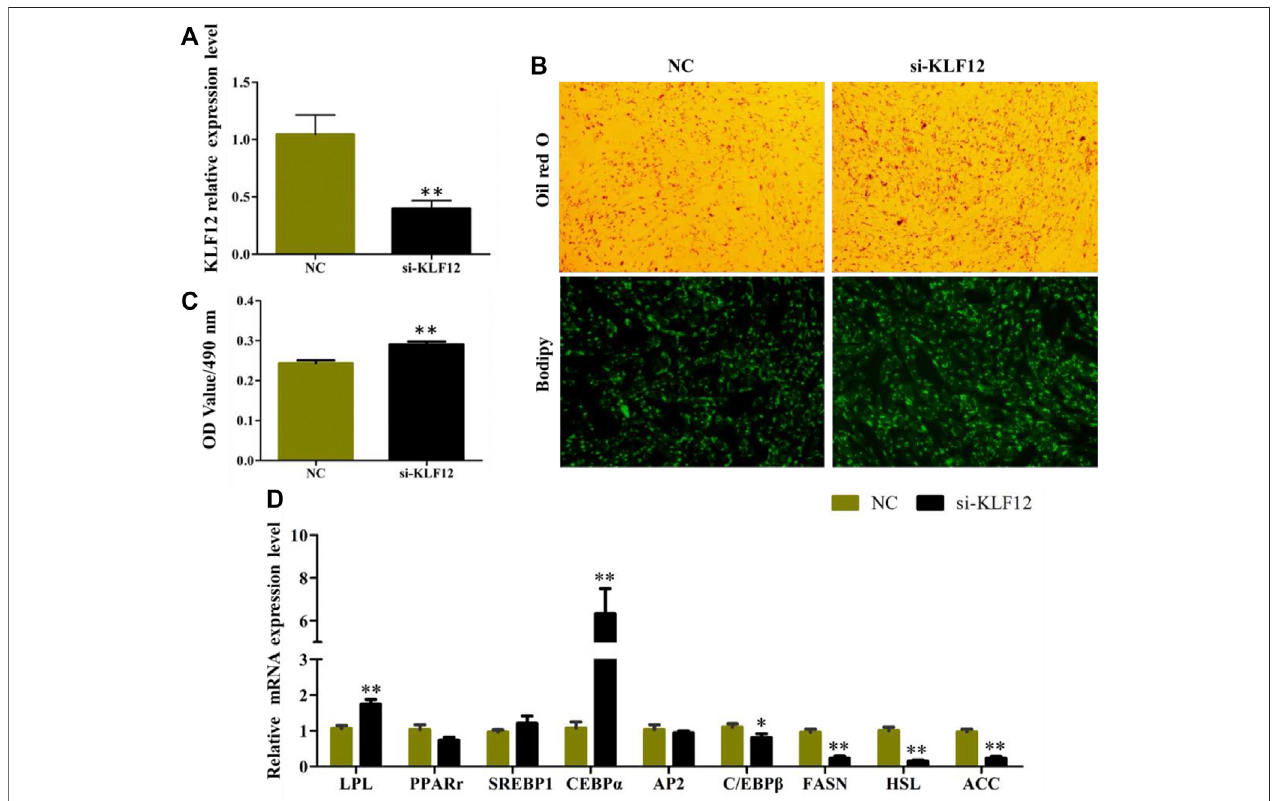
FIGURE 5 | Interference ofKLF12 promoted goat intramuscular adipocyte differentiation. (A) Ef fi ciency of KLF 12 siRNA. (B) Oil red O staining and Bodipy staining ( × 200). (C) OD value at 490 nm. (D) mRNA expression levels of key adipogenic regulatory genes after transfection with si- KLF 12.